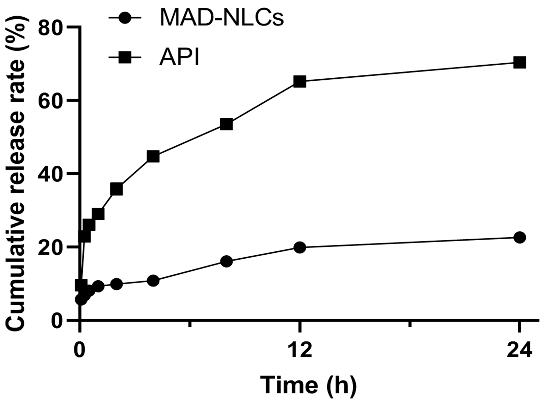
Figure 4. Cumulative release rates of the MAD–NLCs and MAD in PBS solution.